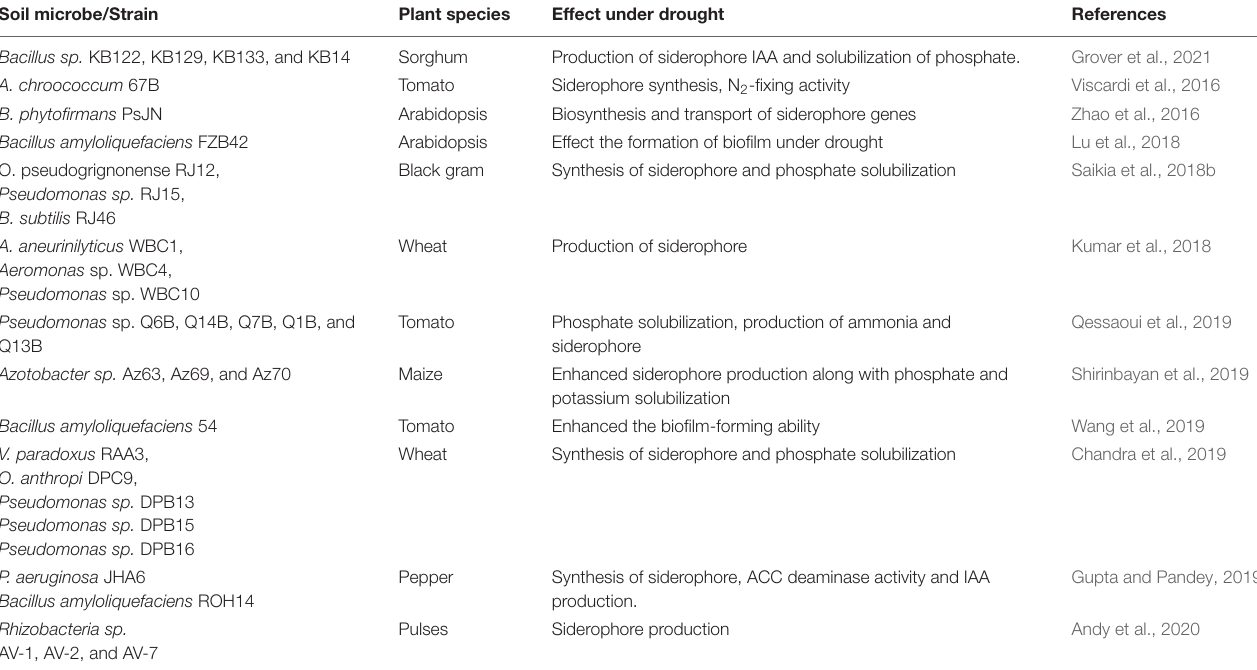
TABLE 8 | Plant growth-promoting rhizobacteria and siderophore production under drought stress.